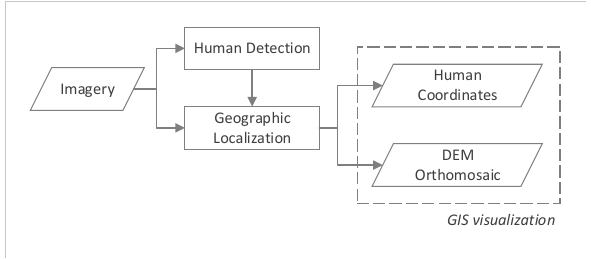
Figure 2. Image processing workflow